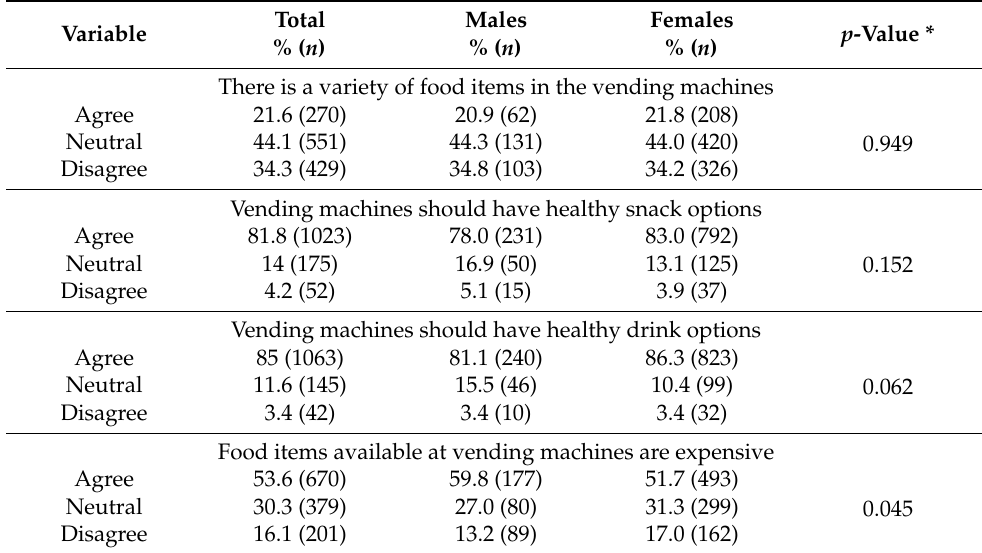
Table 3. Opinions of the study participants about vending machine food items ( n = 1250).